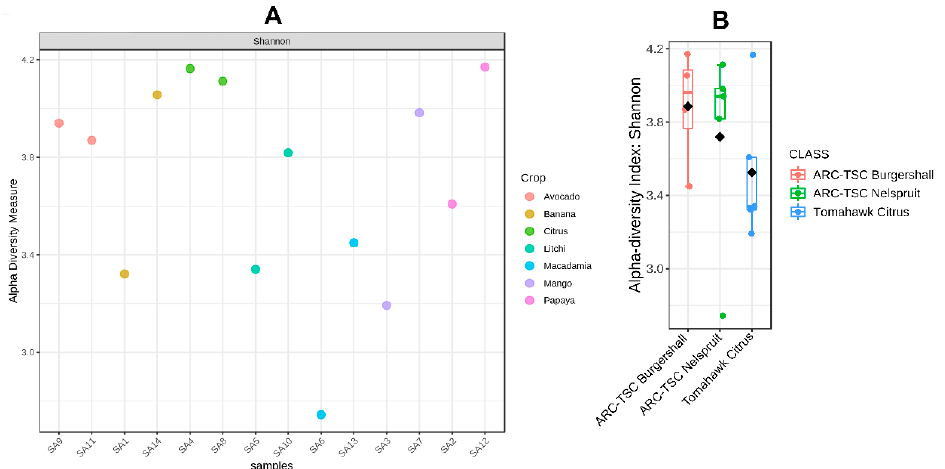
Figure 4. The alpha diversities of the bacterial communities associated with 14 subtropical fruit orchards in Mpumalanga province, South Africa, using the Shannon index. ( A ) Table for each sample; ( B ) alpha diversity biplot for three sampling regions.